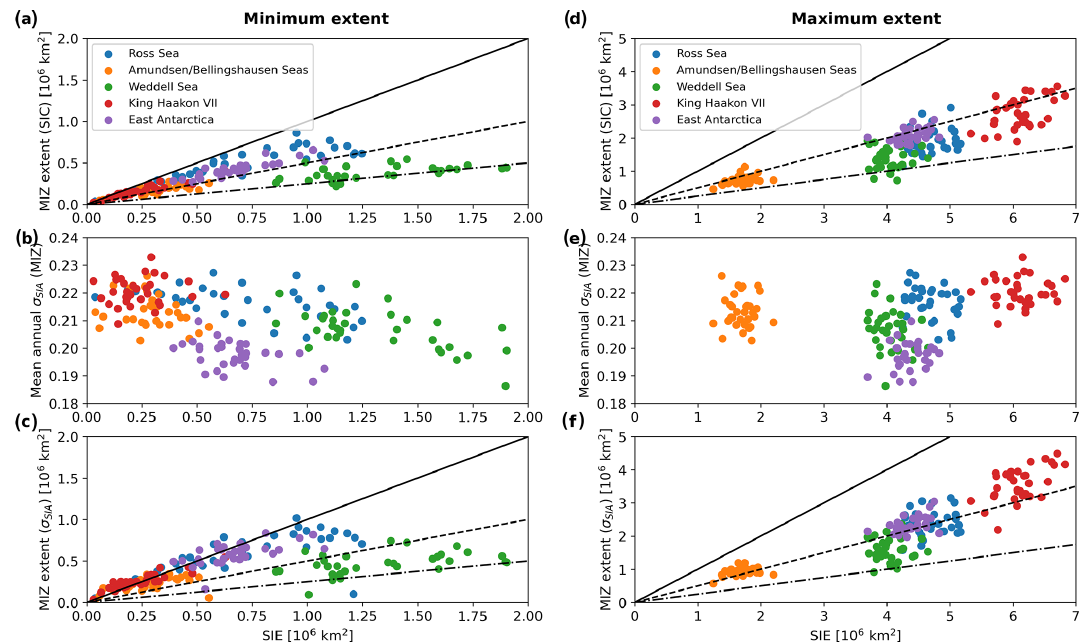
Figure 8. Relationship between the total minimum and maximum sea ice extent (SIE, x axes) and three MIZ properties ( y axes) in the different sectors of the Southern Ocean for the years 1987–2019. (a) Minimum monthly MIZ extent computed using the 0.15–0.80 SIC mask criterion; (b) annual mean of σ SIA , computed for the MIZ pixels where σ m σ m > 0 . 1 mask criterion. (d–f) The same but for the maximum of each year. The lines represent the 100% (continuous), 50% (dashed) and SIA 25% (dash-dotted) MIZ fraction.